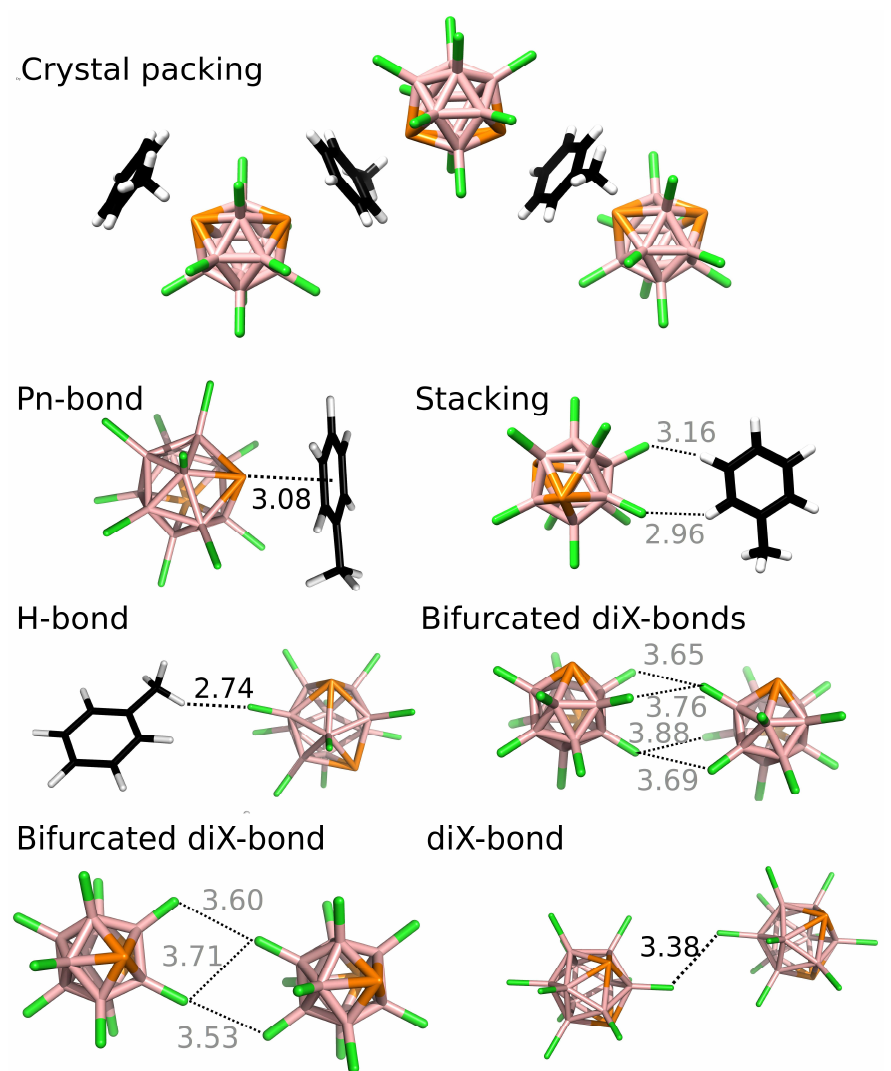
Figure 4. The crystal packing and binding motifs of closo -1,7-P 2 B 10 Cl 10 • toluene. Distances in Å. The color gray is used for distances larger than Σ r vdW . The positions of H atoms were optimized at the DFT-D3/BLYP/DZVP level.